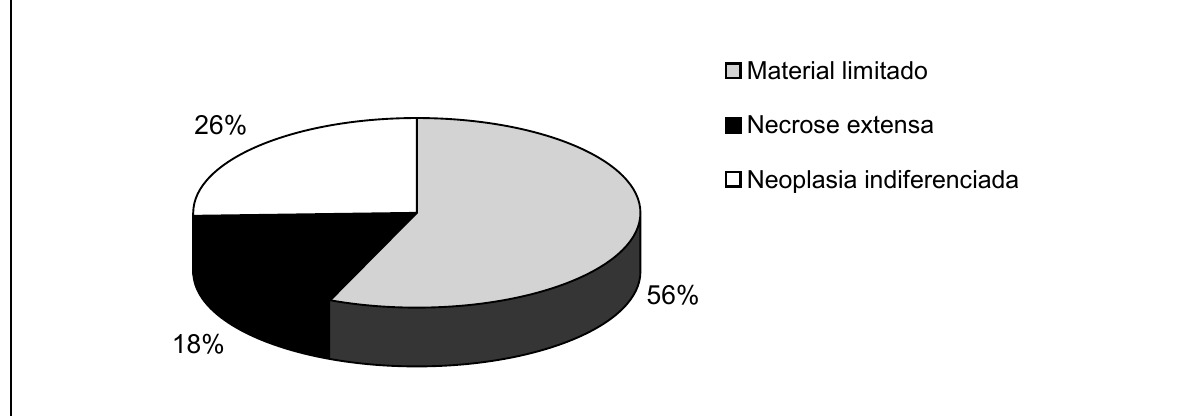
Figura 4 – Motivos pelos quais a imuno-histoquímica não auxiliou no diagnóstico final (n = 39)